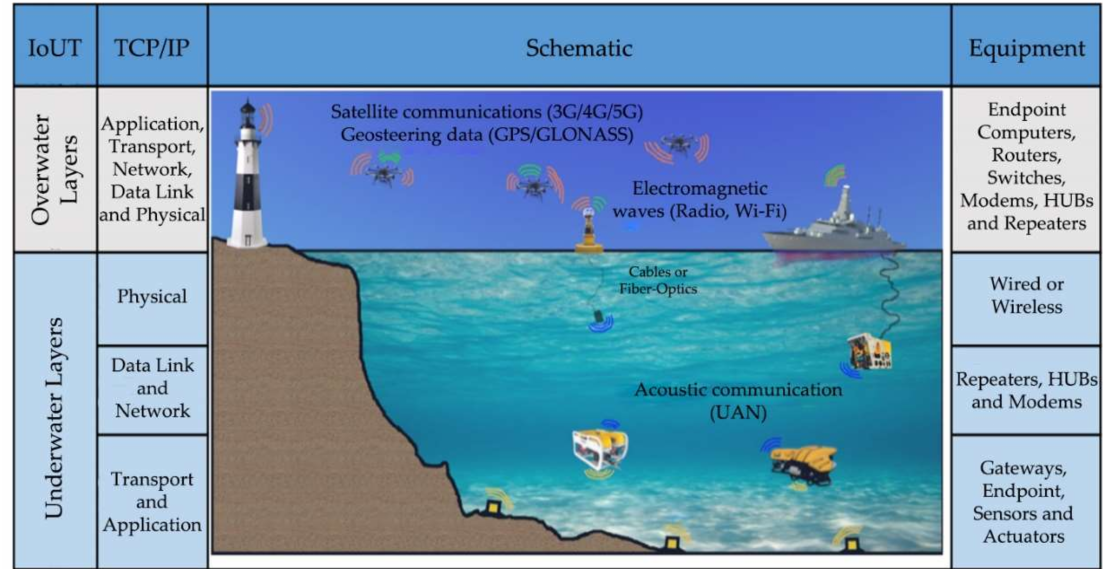
Figure 4. Matching MIoT architectures to the 4-layer TCP/IP